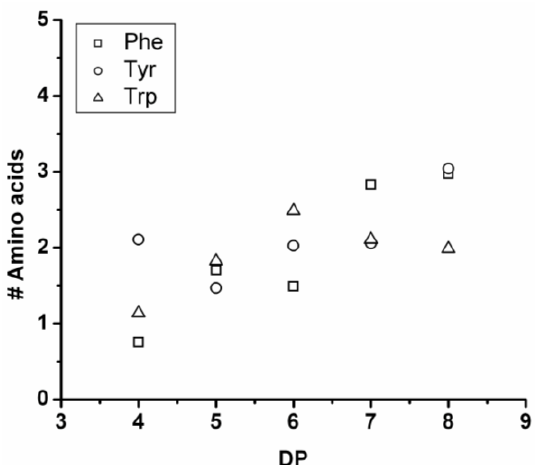
Figure 21. Average number of amino acids in oligo(Phe-co-Tyr-co-Trp) for every observed